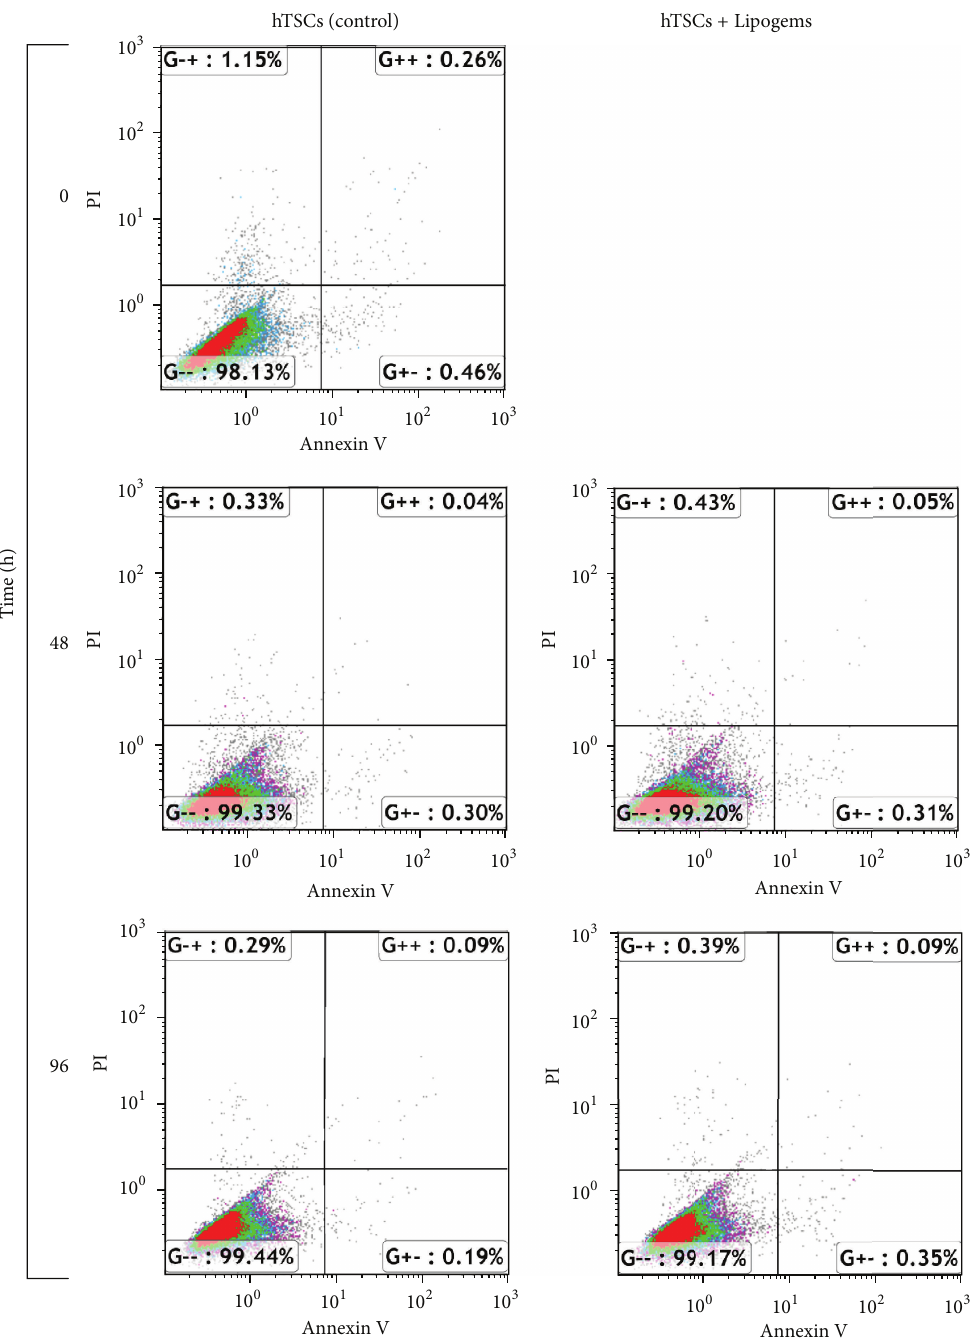
Figure 3: Effects of the Lipogems product on hTSCs apoptosis. Flow cytometric analysis of hTSCs survival rate at 0, 48, and 96 h after the treatmentwiththeLipogemsproduct(rightpanel)ascomparedtocontrolcells(leftpanel),throughdoublestainingwithAnnexinV-FITCand PI. Early apoptotic cells (Annexin V-positive/PI-negative) are localized in the lower right region, late apoptotic and necrotic cells (Annexin V-positive/PI-positive) are localized in the upper regions, and vital cells (double negative) are localized in the lower left